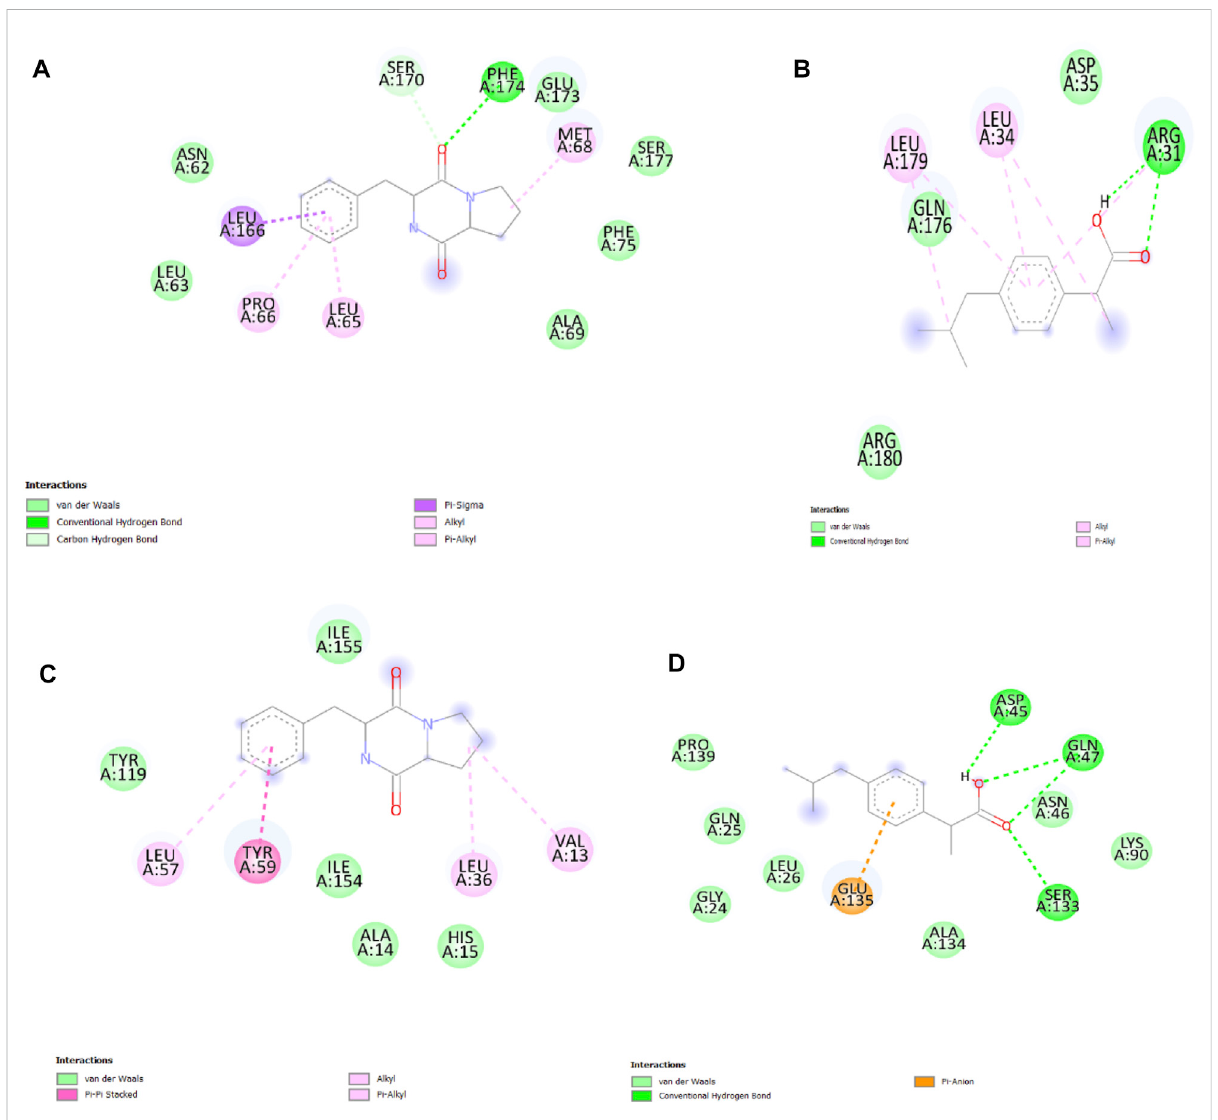
FIGURE 12 (A) 2D interaction of CDPDP with Interleukin-6, (B) 2D interaction of ibuprofen with Interleukin-6. (C) 2D interaction of CDPDP with TNF- α (D) 2D interaction of ibuprofen with TNF- α